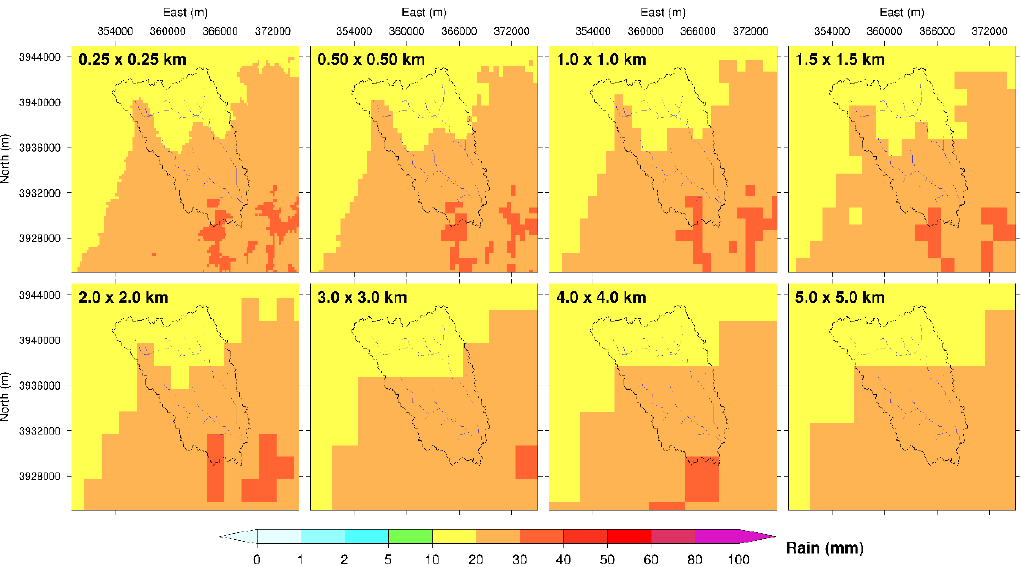
Figure 6 . 2-h accumulated rainfall at different spatial resolutions over the Tsurumi River Basin and its periphery at 17:00–18:00 UTC on 5 May 2012.